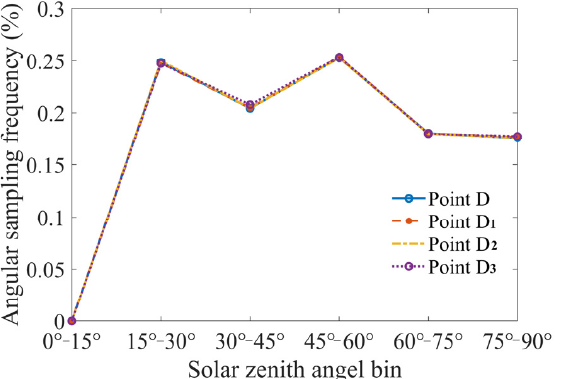
Figure 4. Angular sampling frequency of Point D, Point D 1 , Point D 2 , and Point D 3 show similar distribution.